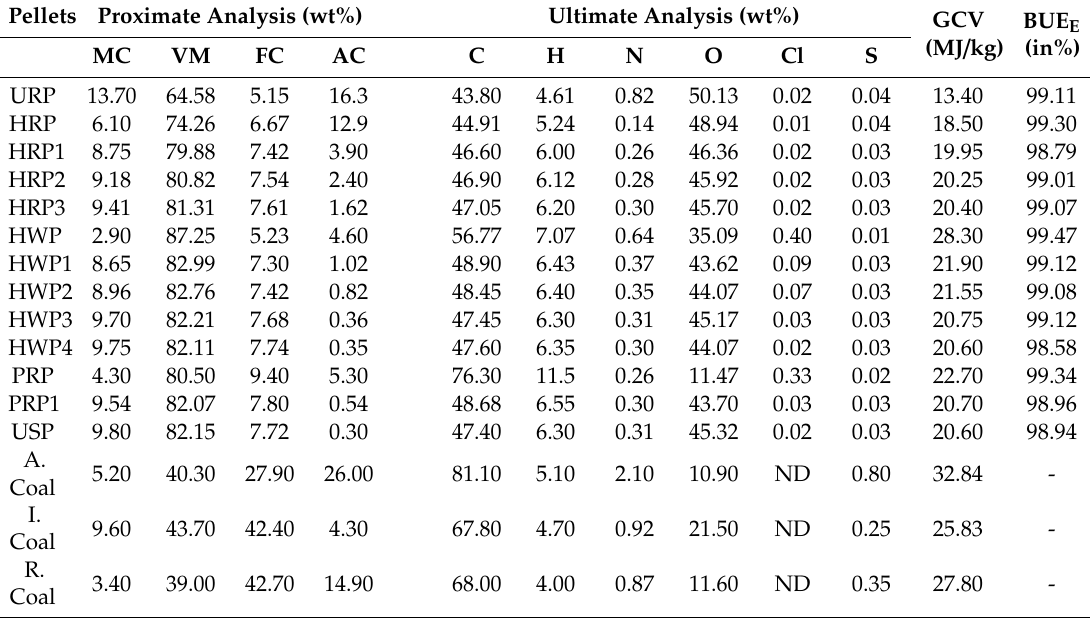
Table 5. Physicochemical characteristics, gross calorific value, and energetic biomass utilization e ffi ciency (BUE E ) of di ff erent fuel